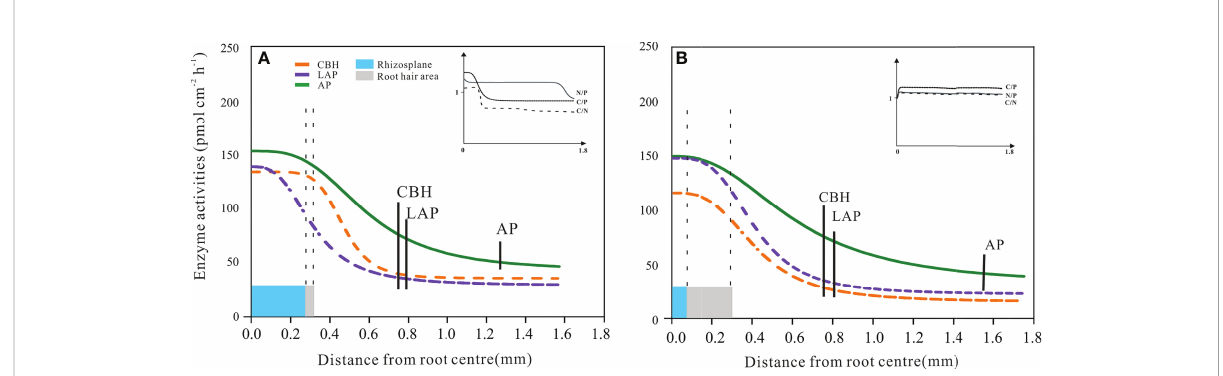
FIGURE 6 Distribution of enzyme activities in the European beech (A) and Norway spruce (B) rhizosphere. The curves represent the Hill function fi tting the enzyme activity related to the horizontal distance from the root centre. Cellobiohydrolase (CBH), leucine-aminopeptidase (LAP), and acid phosphomonoesterase (AP). The vertical dotted lines represent the size of the root radius (blue area) and root hair length (grey area). The vertical solid bars represent the end of the extent of enzyme activity for CBH, LAP, and AP. The models include the mean data from 7 vertical measuring points per radial measurement point per plant. (N = 4). Error bars of enzyme activities were omitted to improve visualisation; the standard errors were always less than 10% of the activity